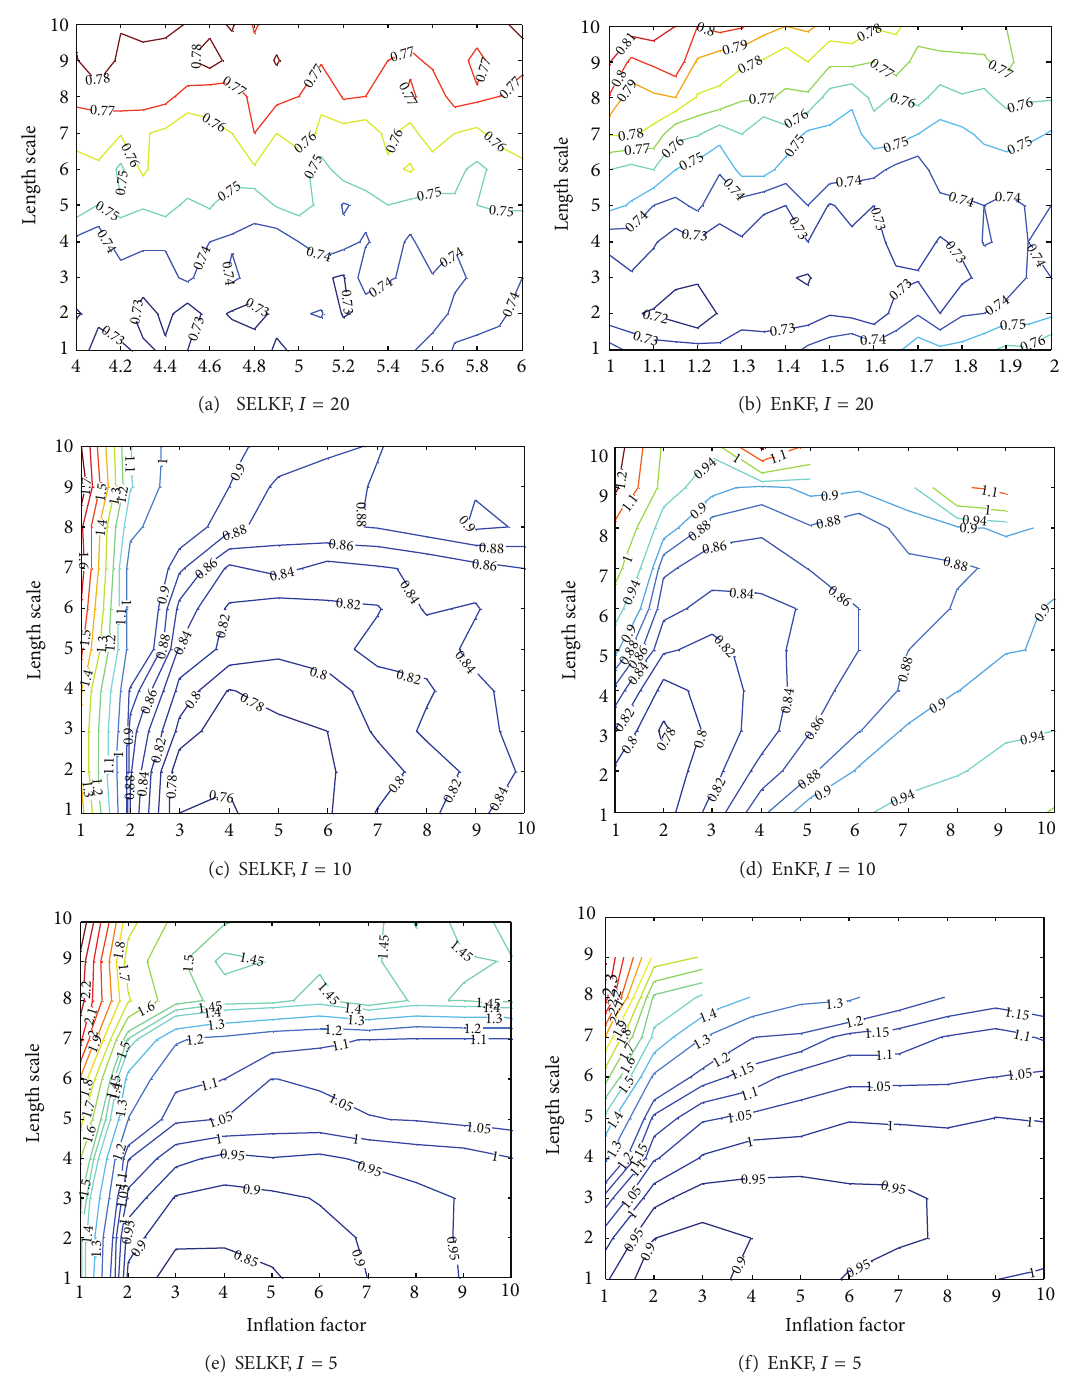
Figure 1: Parameter dependence of the analysis RMSE of two methods. The horizontal and the vertical axes indicate the inflation factor and the length scale,